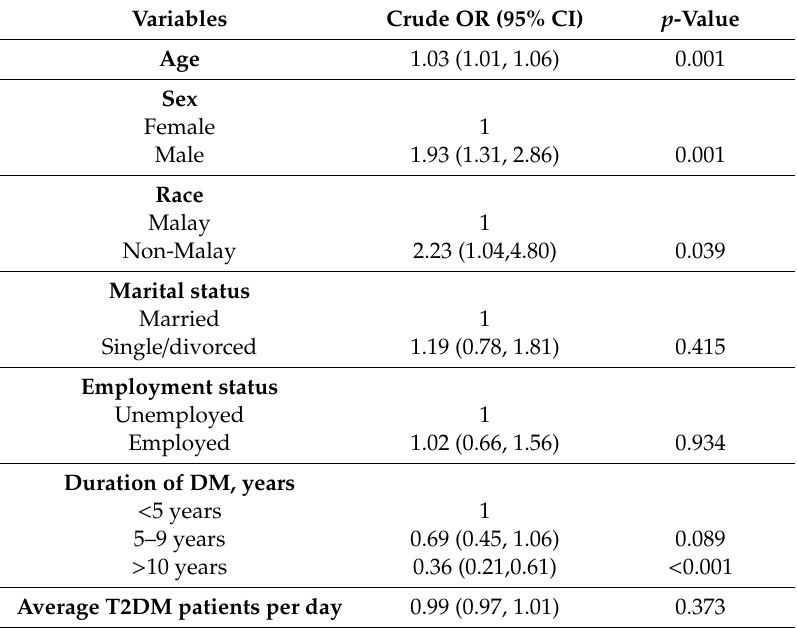
Table 4. Factors associated with good glycaemic control among T2DM patients in Kelantan by simple logistic regression ( n =